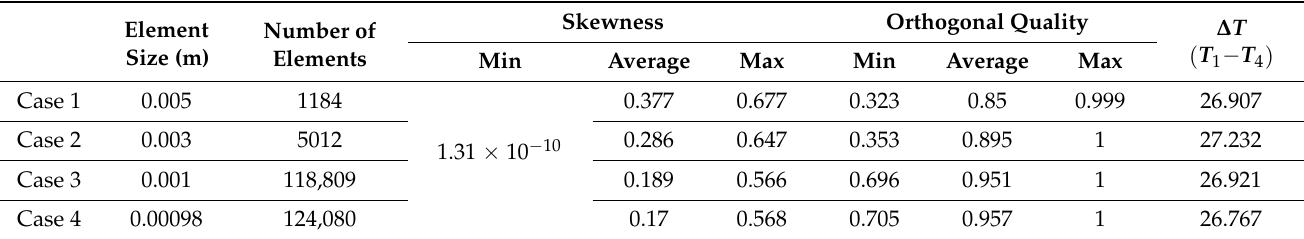
Table 3. Sensitivity Analysis of Grid Quality: Model